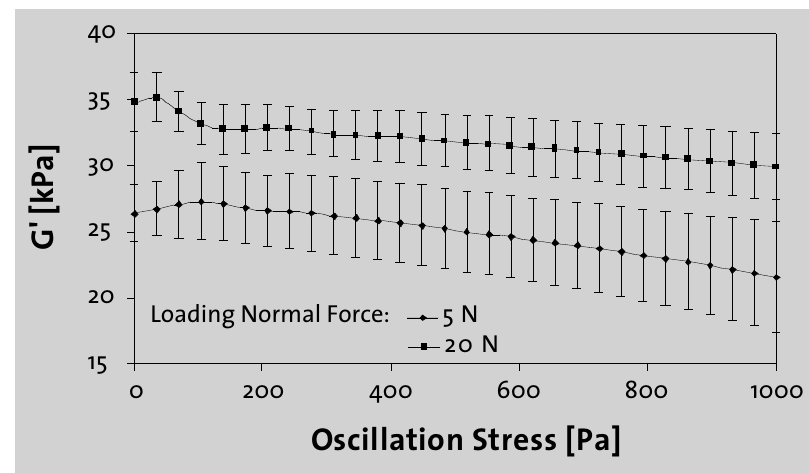
Figure 1 (above): Stress ramp (at 10 Hz) of fat-free bologna samples loaded to 5 N or 20 N normal force. Storage moduli (G’) values shown are the average of 12 samples, error bars represent +/- one SD.